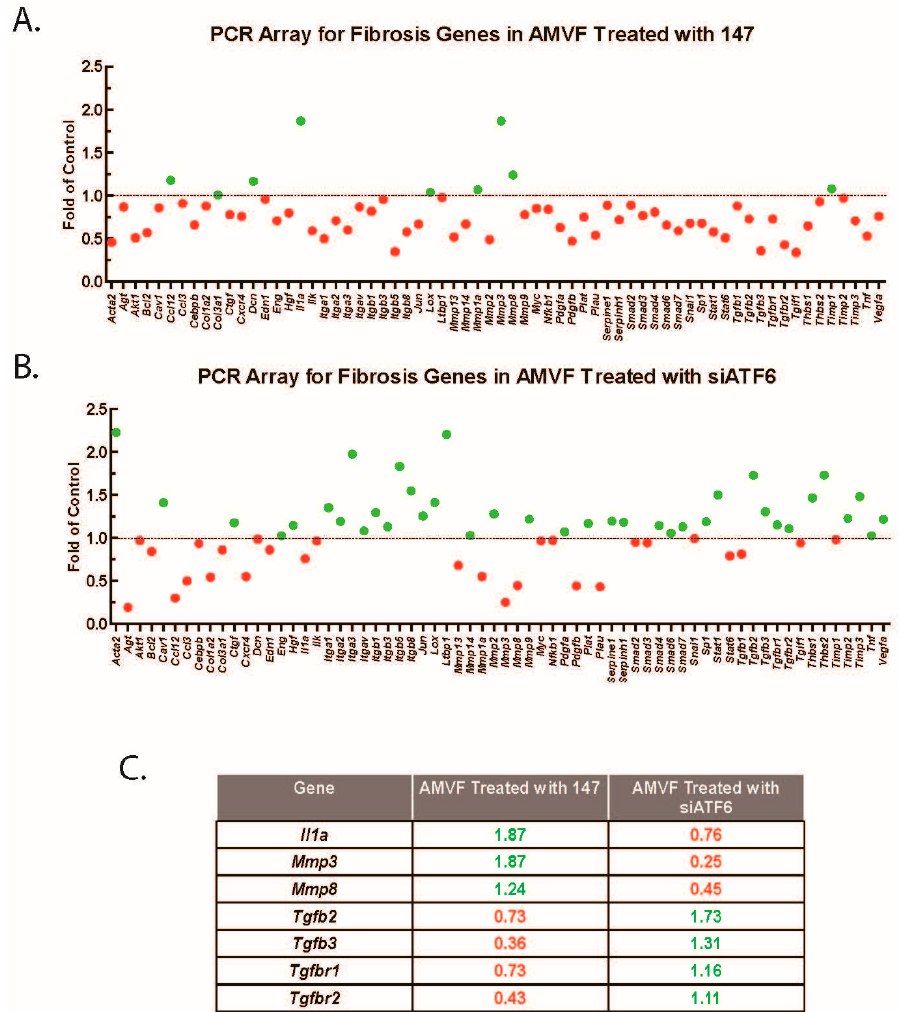
Figure 7. PCR array for fibrosis genes in AMVFs. AMVFs were treated with ( A ) ± 10 µ M compound 147 or ( B ) ± siRNA to ATF6; all cultures were treated for 48 h, then analyzed by a qRT-PCR array as described in the Methods (Section 4). In ( A , B ) green and red dots represent up- and downregulated genes, respectively. ( C ) A subset of differentially regulated genes from panels A and B; green and red numbers represent the fold up- or downregulation, respectively.